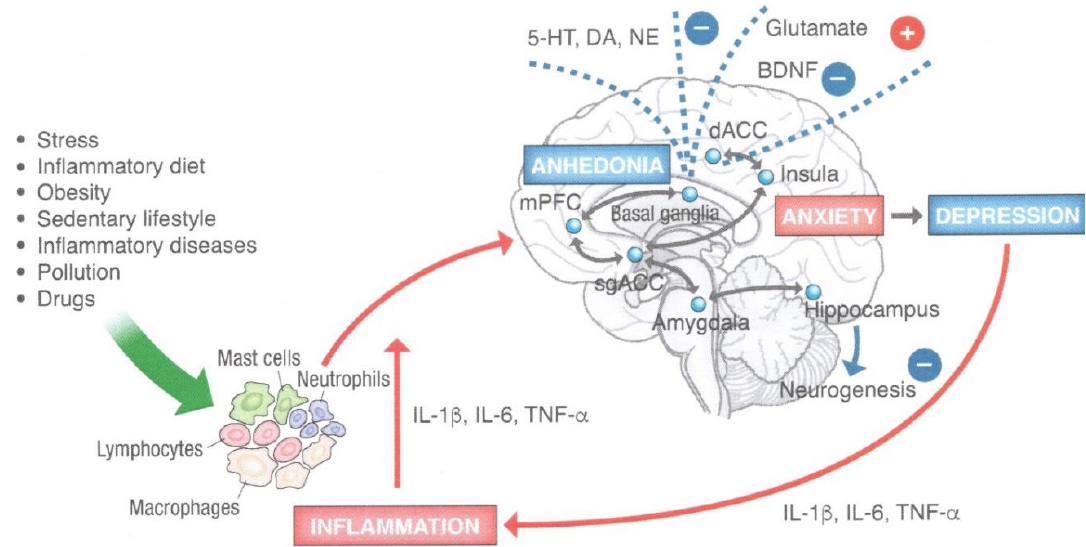
Figure 1. The bidirectional relationship between depression and inflammation. The image illustrates the inflammatory effects of several factors, starting with stress. The release of inflammatory cytokines by immune cells alters the metabolism of fundamental neurotransmitters such as serotonin, norepinephrine, dopamine, BDNF, and glutamate, reducing the levels of the first four and increasing those of the last. These alterations negatively affect the activity of strategic brain areas and their mutual connections. There are psychological consequences, with the inability to experience pleasure (anhedonia), anxiety, depression, and poor self-esteem; and biological, with alterations in the medial prefrontal cortex, the anterior cingulate cortex, the basal ganglia, the amygdala, the hippocampus, and the insula. 5-HT = serotonin; BDNF = brain-derived nerve factor; DA = dopamine; dACC = dorsal anterior cingulate cortex; mPFC = medial prefrontal cortex; NE = norepinephrine; sgACC = subgenual anterior cingulate cortex. Reprinted with permission from: F. Bottaccioli, A.G. and Bottaccioli (2020). Copyright 2020